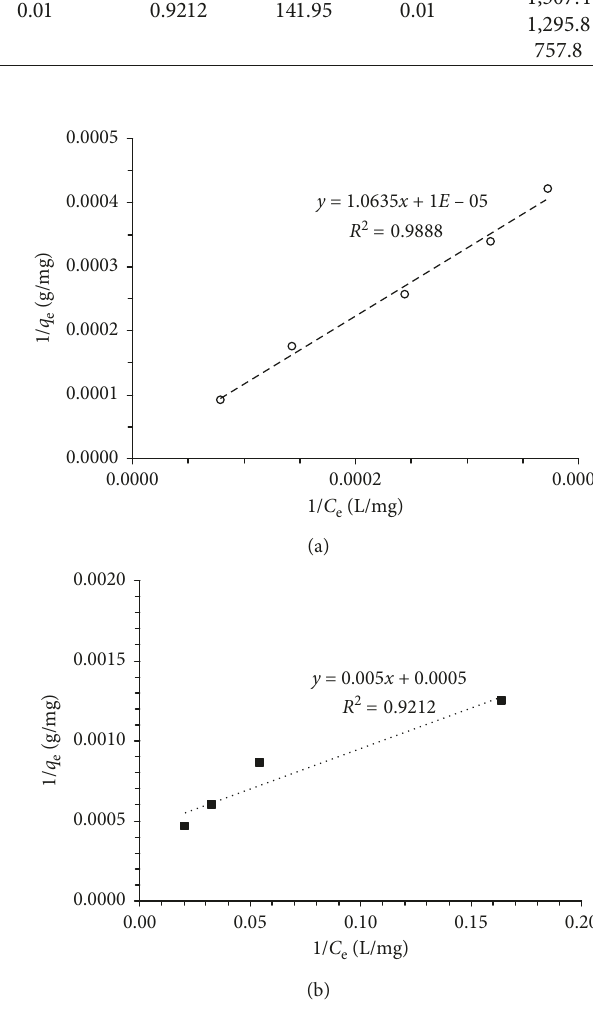
Figure 7: Langmuir isotherm plot using modified bagasse under (a) laboratory and (b) pilot